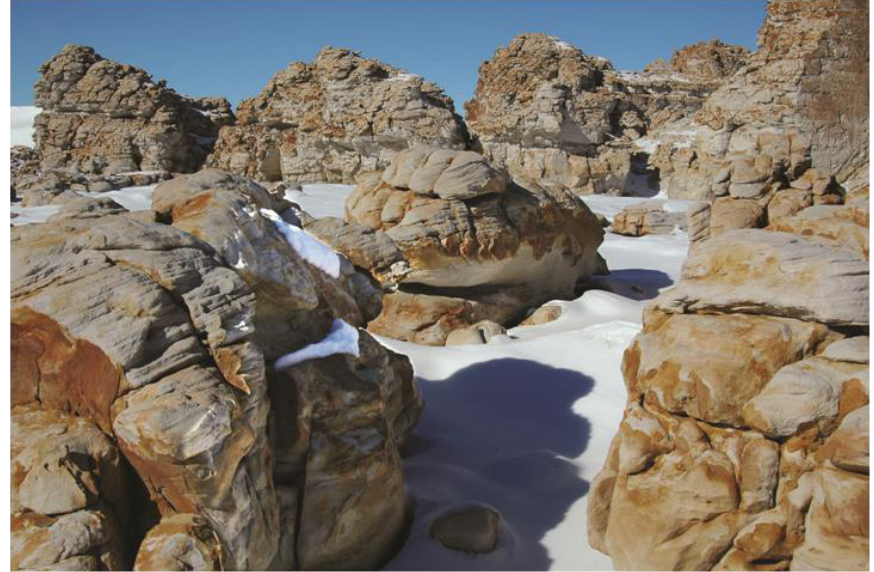
Figure 1. Relationship between rock slope, orientation, and biological activity on Battleship Promontory, Convoy Range, Antarctica. North is to the lower left corner of the photograph (note shadow on the ground). Vertical surfaces are devoid of organisms, as is evident from their dark red coloration, because they cannot trap snow. Sloped surfaces are colonized and show exfoliation, regardless of orientation (boulders in foreground), because they trap some snow, but excess snow is removed by gravity and wind. Heavily-scoured surfaces are devoid of colonization. The rate of scouring is such that the organisms are unable to establish a